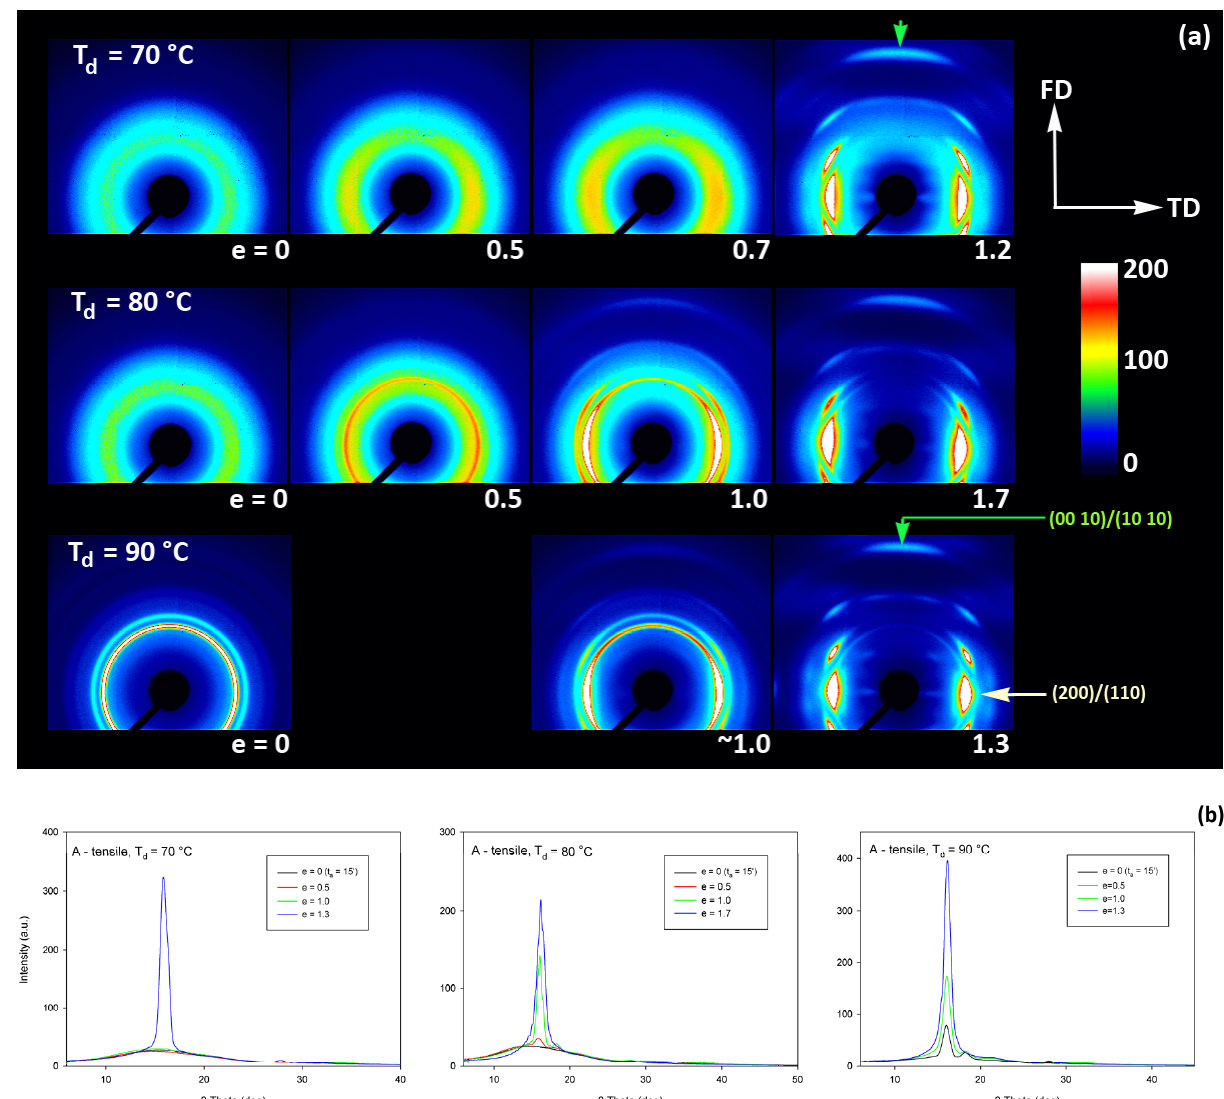
Figure 9. ( a ) 2D-WAXS patterns of the initially amorphous A samples deformed in uniaxial tension at temperature T d = 70 °C ( top row ), T d = 80 °C ( middle row ), T d = 90 °C ( bottom row ) obtained in transmission with the X-ray beam illumination normal to the plane of the sample. The true strain indicated for each pattern is the local true strain calculated from the distance of the ink marks printed on the sample. ( b ) One-dimensional radial sections derived from 2D images along the transverse direction, TD—obtained by azimuth integration of 2D patterns in the azimuth range ( − 5°, +5°) around TD ( ψ TD = 0°).